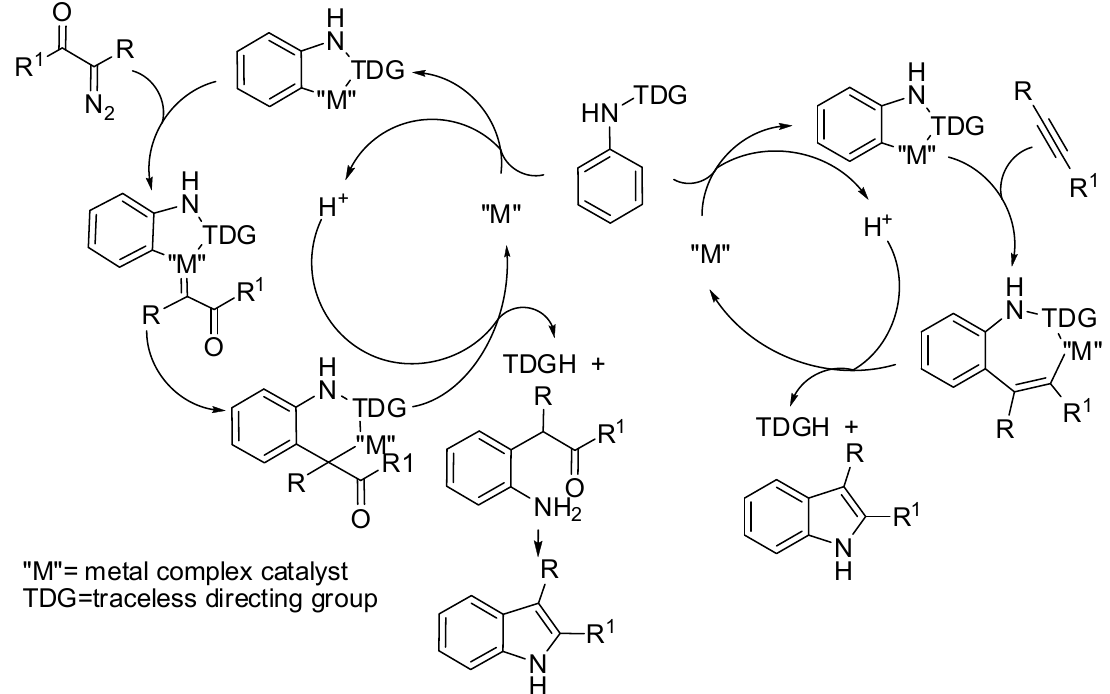
Scheme 1. Accepted mechanism for C–H activation reaction with traceless directing group.